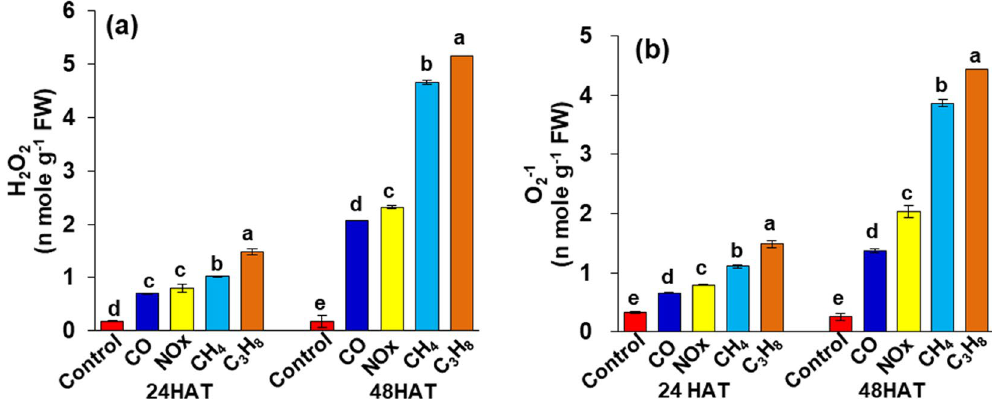
Figure 1. Oxidative damage in leaves indicated by ( a ) H 2 O 2 ( b ) O 2 − 1 determination as affected by CO, NO x , CH 4 and C 3 H 8 compared to control at 24 and 48 hours after treatment. Vertical bars indicate ± SE by means with n = 3. Means denoted by the different letter are significantly different at p < 0.05 according to the Tukey’s studentized range